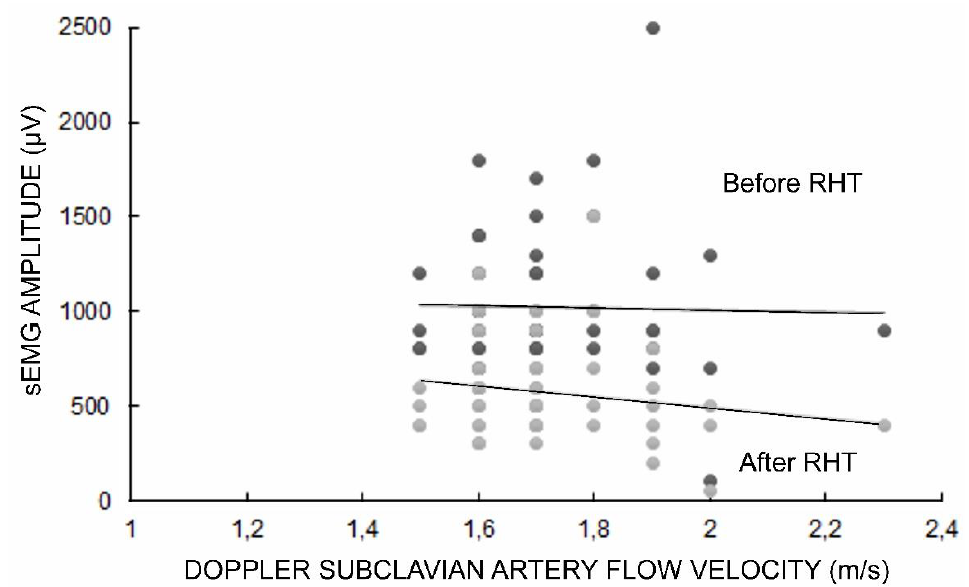
Figure 2. Graphical presentation of relationships between positive Doppler test results (indicating pathological changes in the subclavian flow velocity), and maximal contraction sEMG amplitude recordings before and after RHT tests in TOS patients on the symptomatic side. Some points representing parameters of sEMG vs. Doppler results are overlapped multiple times with their Y-X locations. Black dots refer to results before RHT, while grey dots refer to after RHT.